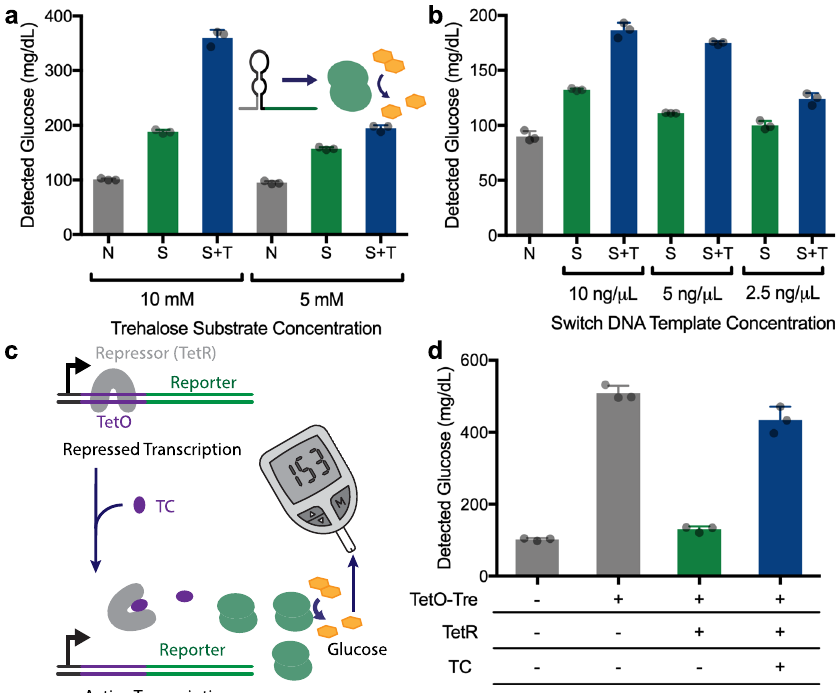
Fig. 2 Demonstration of gene circuit-based sensors linked to a glucose output. a Effect of trehalose substrate concentration on glucose output levels in a blank CFS reaction (N, negative control), or reactions with toehold switch-regulated glucose production in the absence (S, switch only) or presence (S + T, switch and trigger) of the corresponding trigger RNA. Switch and trigger added to 10 ng/ µ L DNA. N = 3 biological replicates, error bars represent mean ± SD. b Effect of different switch DNA template concentrations on glucose output in the absence (S, switch only) or presence (S + T, switch and trigger) of the corresponding trigger, shown with a CFS without any added DNA (N, negative control) for background comparison. Trehalose present at 5 mM. c Schematic of an alternative gene circuit for small molecule detection, based on the TetO/TetR inducible system. The repressor element regulates trehalase expression in response to tetracycline. d Demonstration of the system shown in c in practice. As seen in the control reactions, TetO-Tre expression results in high glucose production in the absence of both TetR and tetracycline (TC). With the addition of the TetR, glucose production is reduced to near background levels. The addition of both TetR and tetracycline, however, results in a signi fi cant increase in glucose output levels. All data presented are the mean of N = 3 independent experiments (as indicated by dot plots) ±SD Source data are provided as a Source Data fi